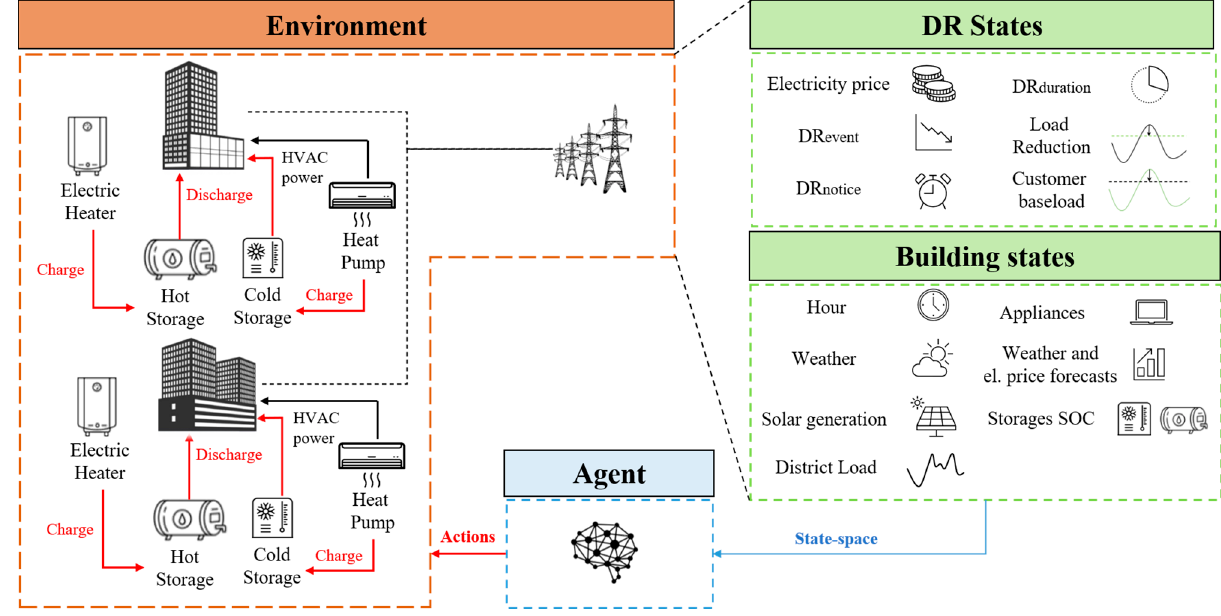
Figure 6. State and action spaces for the DRL controllers.